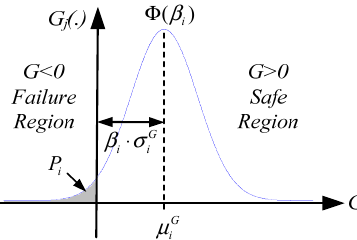
Figure 4. The probabilistic analysis method.